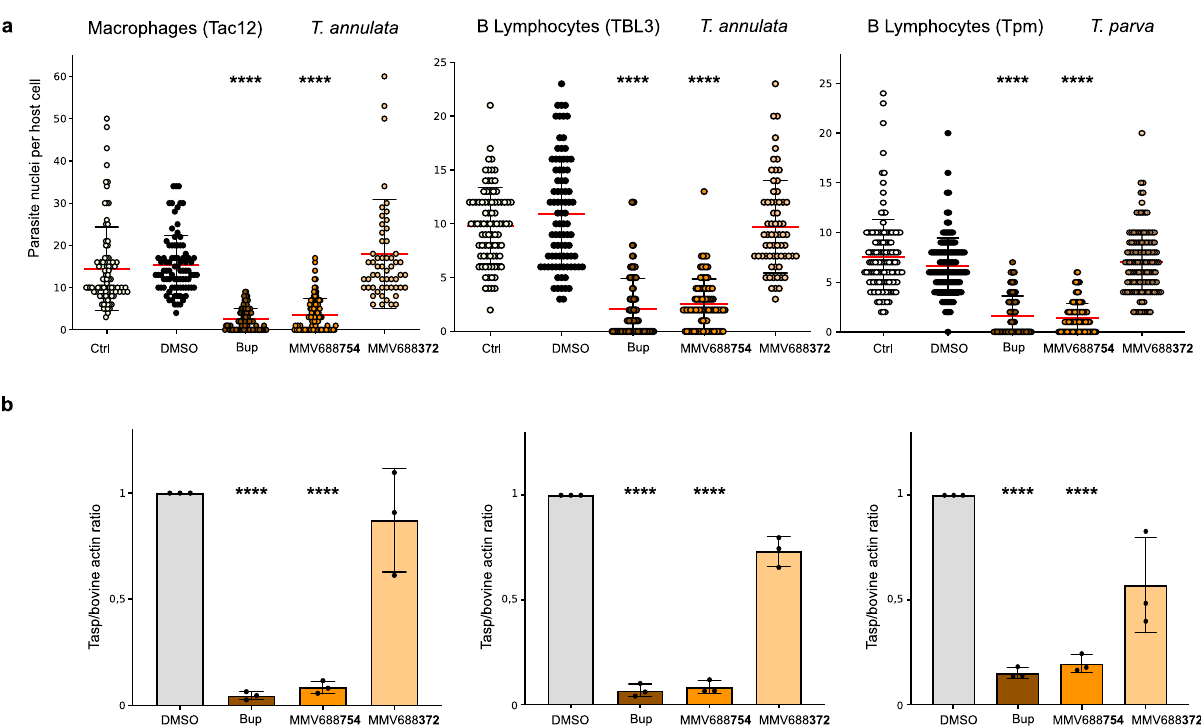
Fig. 4 Drug effects on parasite number and gene expression in different parasite species and host cell types. a Parasite load per infected host cell was evaluated after drug treatment (2 µ M for 48 h) compared to untreated (Ctrl), Buparvaquone (Bup) or DMSO-treated cells. Host cells (at least n = 50) were assessed for each experiment and parasite nuclei (DAPI staining) per host cell were counted manually. These results are representative of 3 independent experiments. Kruskal Wallis non-parametric test followed by Dunn ’ s multiple comparison test. **** p < 0.0001. Results are shown for T. annulata -infected macrophages (TaC12), B lymphocytes (TBL3) or T. parva -infected (TpM) lymphocytes. b Assessment of parasite viability using quantitative RT-qPCR analysis of parasite TaSP expression relative to bovine actin mRNA expression (host or parasite targeted fi rst by the drug) in the three different cell lines compared to DMSO or Buparvaquone (Bup) treatment. Mean values± SD. One-way Anova statistical test, Dunnett ’ s multiple comparison test: **** p <